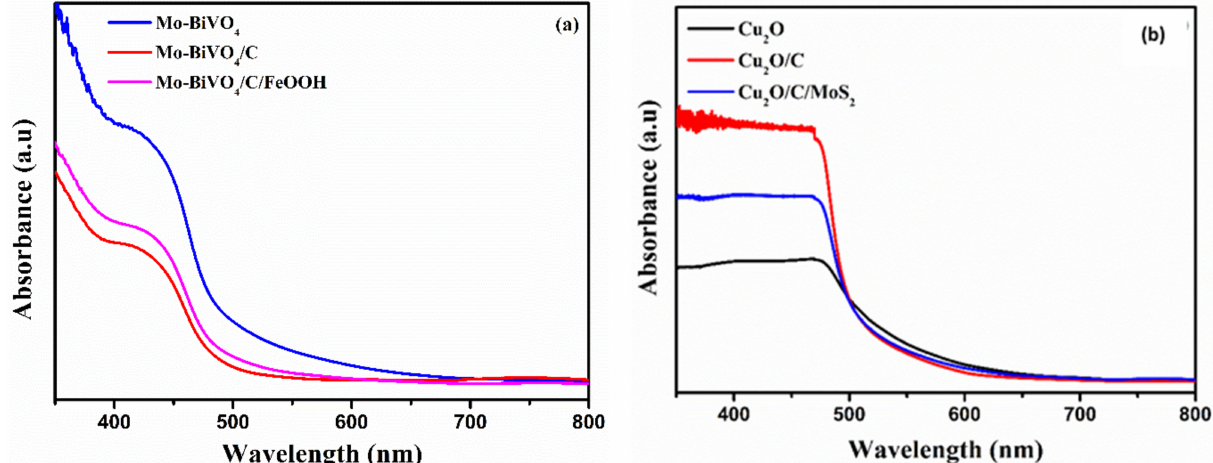
Figure 3. UV-Vis absorption spectra of ( a ) Mo-BiVO 4 , Mo-BiVO 4 /C, and Mo-BiVO 4 /C/FeOOH photoanodes; ( b ) Cu 2 O, Cu 2 O/C, and Cu 2 O/C/MoS 2